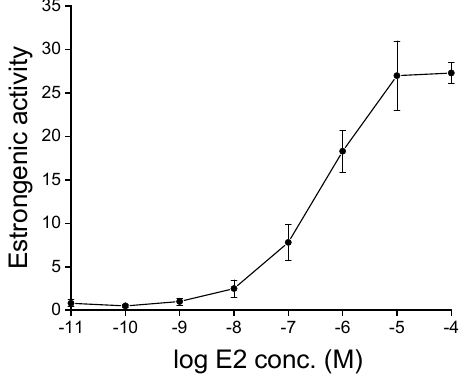
Figure 1. Dose–response relationship for estrogenic activity in yeast exposed to E2.